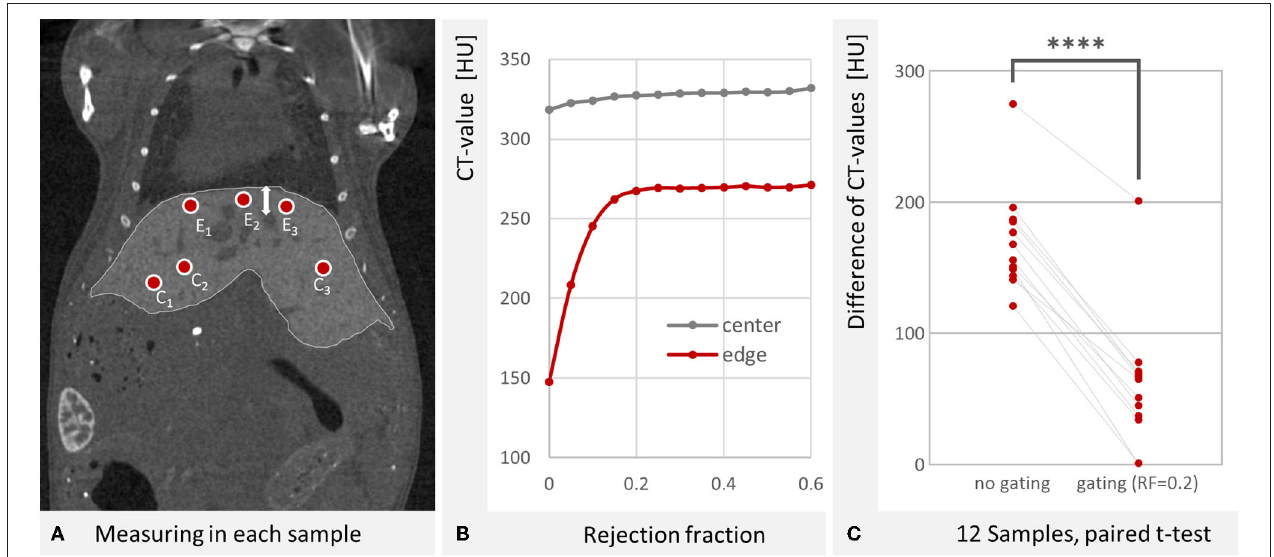
FIGURE 8 | Gating reduces the hypodensity at the liver edge. (A) Evaluated regions at the center of the liver C 1 − 3 and near the edge toward the diaphragm E 1 − 3 . The gasping breathing results in a motion of the lungs and liver as shown by the white arrow. At the cranial liver edge (E 1 − 3 ), the contribution of motion projections causes a hypodense depiction. Image reconstructed with RF = 0.2. W: 4,014 HU L: 668 HU (B) The hypodense depiction at the liver edge is reduced with increasing rejection fractions. For RF > 0.2 no noticeable improvement is found. (C) The difference between liver center and edge CT-values is significantly reduced by gating (for RF = 0.2, n = 12, p < 0.0001 as indicated by ****, paired t -test).